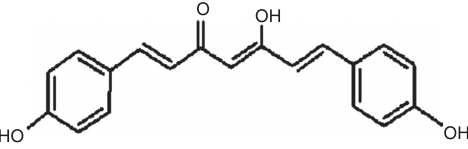
Figure 3: Structure of